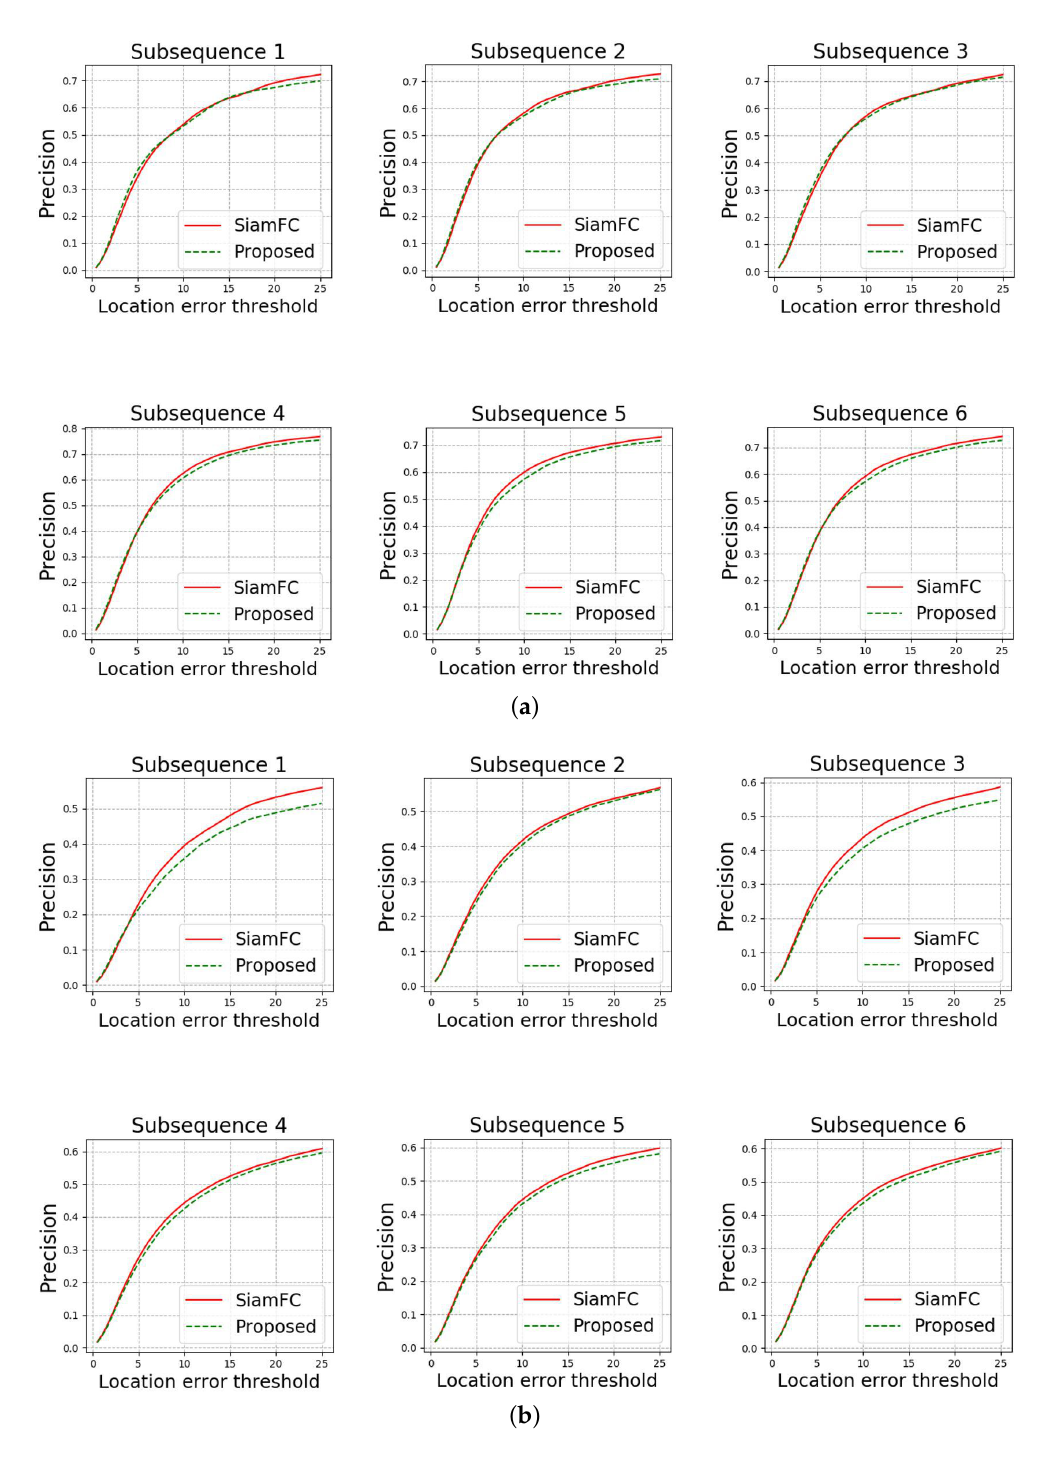
Figure 3. The precision plot of ( a ) VOT2014 and ( b )